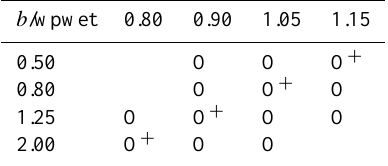
Table 1. Combinations of parameters with efficiency score higher than 80% for surface and 70% for root zone soil moisture. Com- binations along the anti-diagonal (marked with superscript “+”) are used in the combined uncertainty experiments (Sect. 3.4).